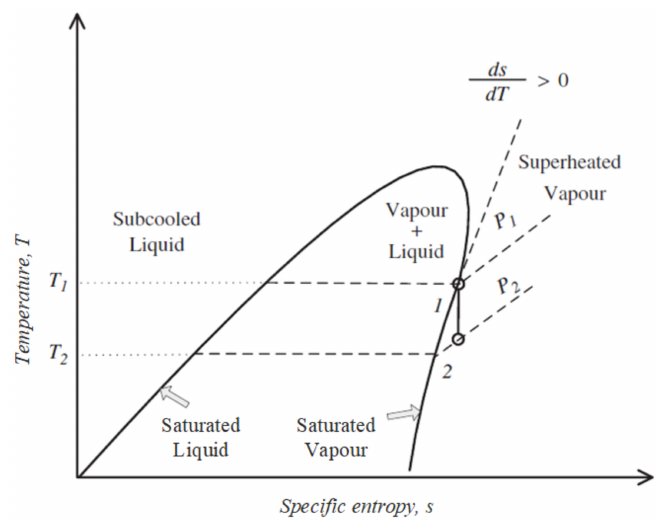
Figure 4. Temperature vs. specific entropy saturation curve of a dry fluid